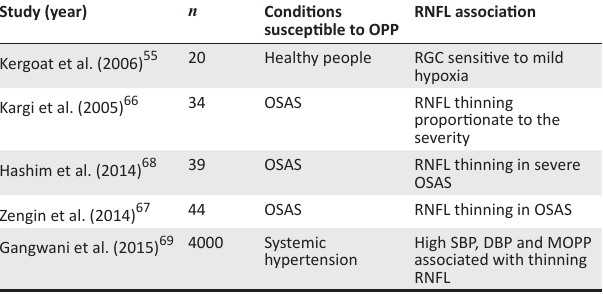
TABLE 3: Studies showing retinal changes from reduced retinal perfusion. Study (year)